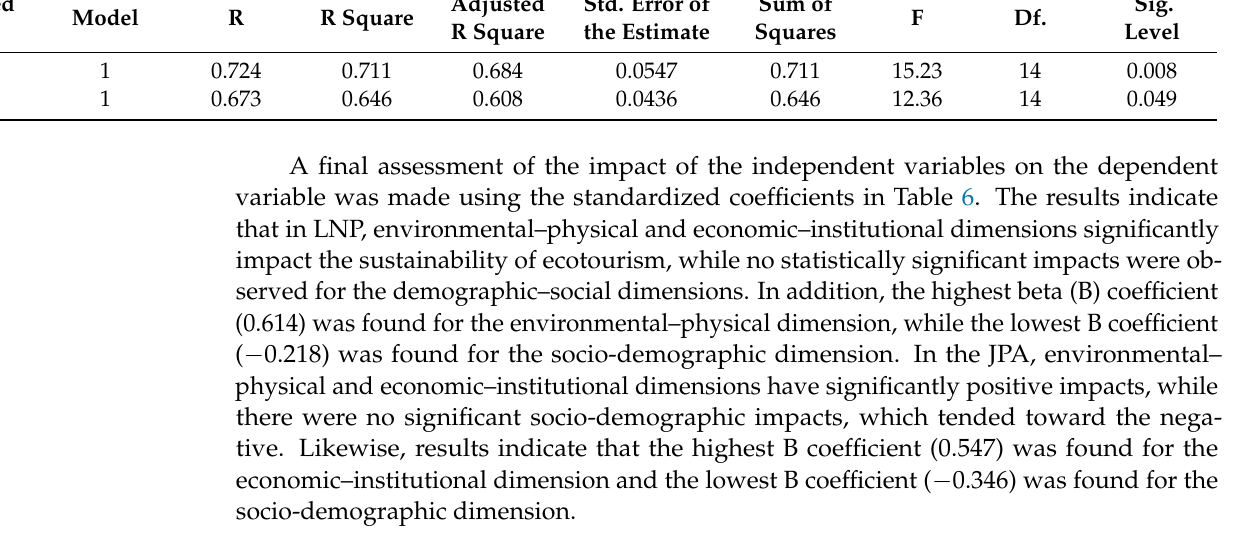
Table 6. The impact intensity coefficients of participation dimensions on ecotourism